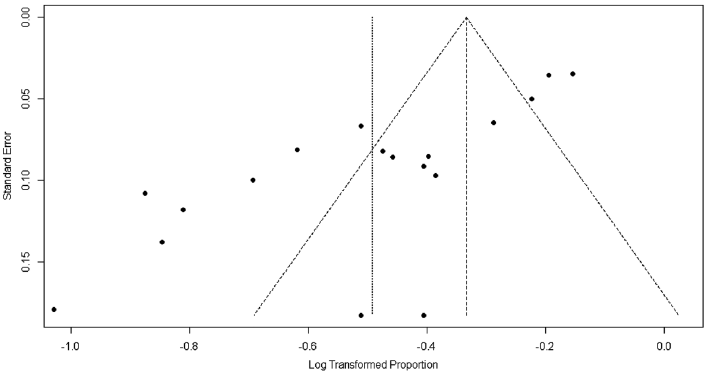
Figure 3. Funnel plot (publication